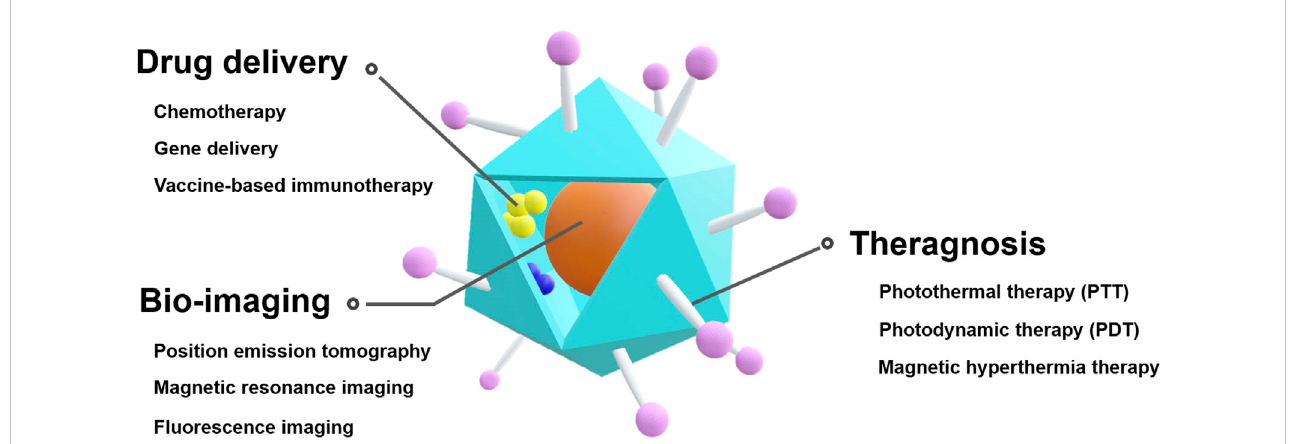
FIGURE 1 Schematic illustration of VLP-based theranostic platform for cancer therapy and